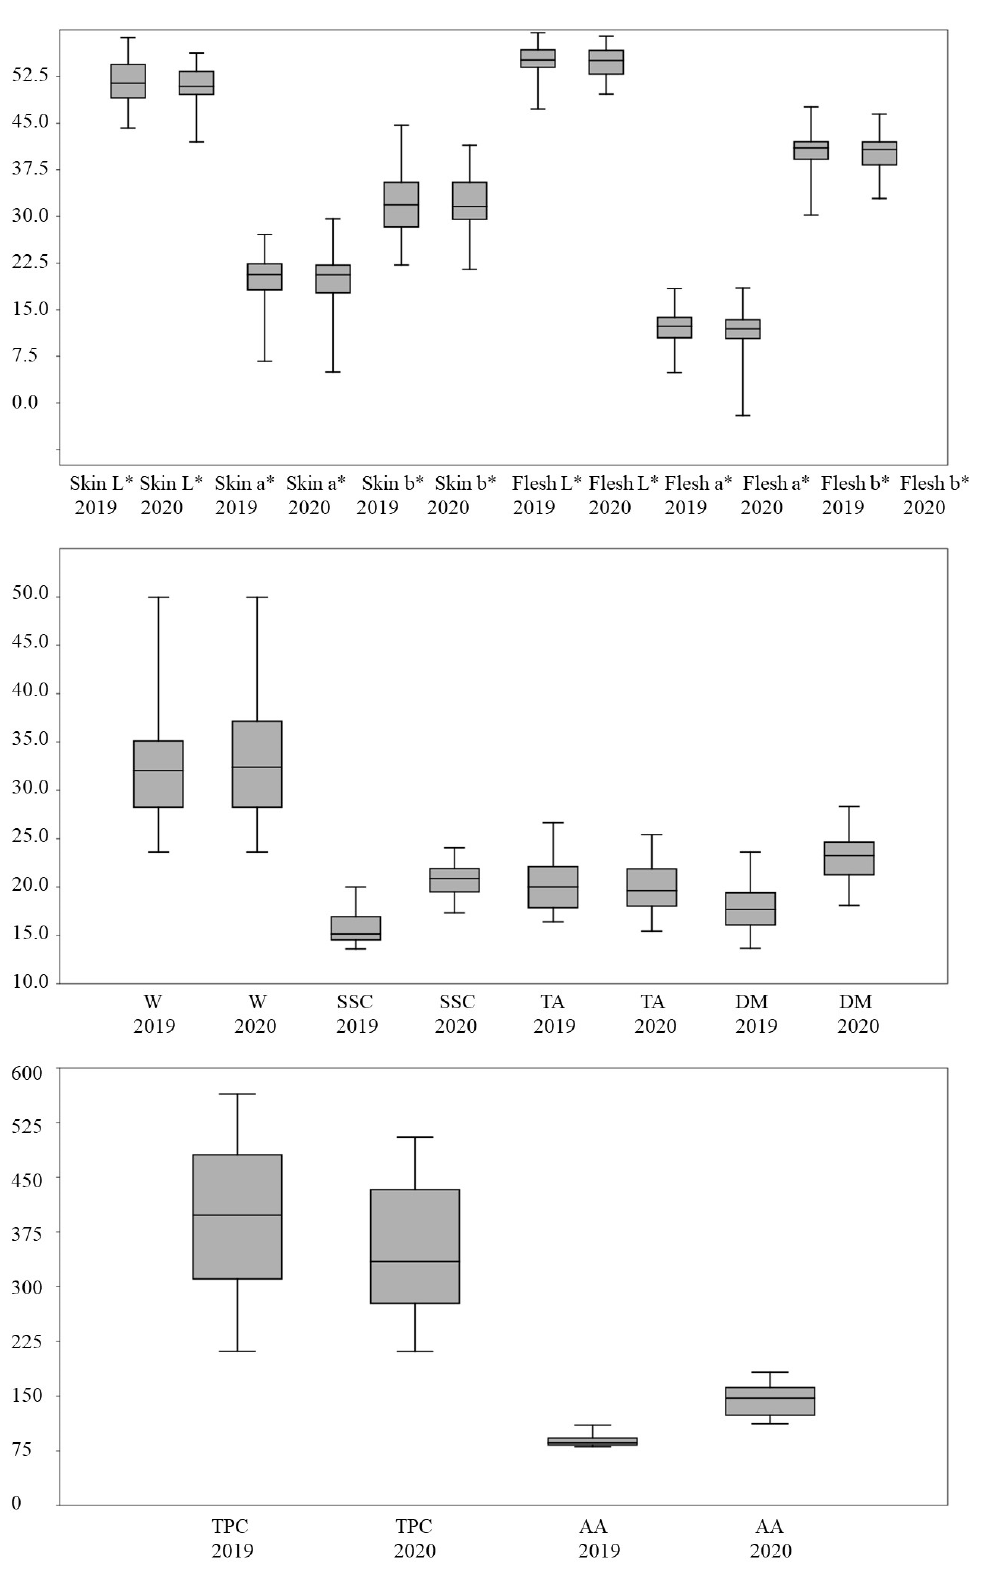
Figure 2. Box plots of CIELab coordinates of skin and flesh (Skin L*, Skin a*, Skin b*, Flesh L*, Flesh a*, and Flesh b*); W = weight (g), SSC = soluble solids content (g 100 g − 1 FW), TA= titratable acidity (g MA 100 g − 1 FW), DM = dry matter (g 100 g − 1 FW), TPC= total phenolic content (mg GAE 100 g − 1 FW), and AA = antioxidant activity ( µ g TE 10 g − 1 FW) per